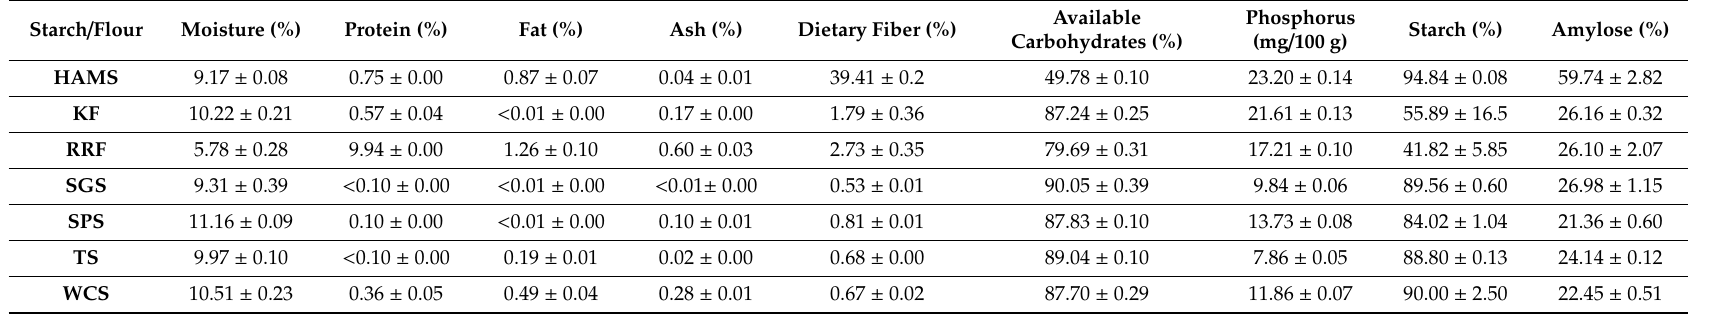
Table 1. The chemical composition of the starch and flour (data are means ± standard